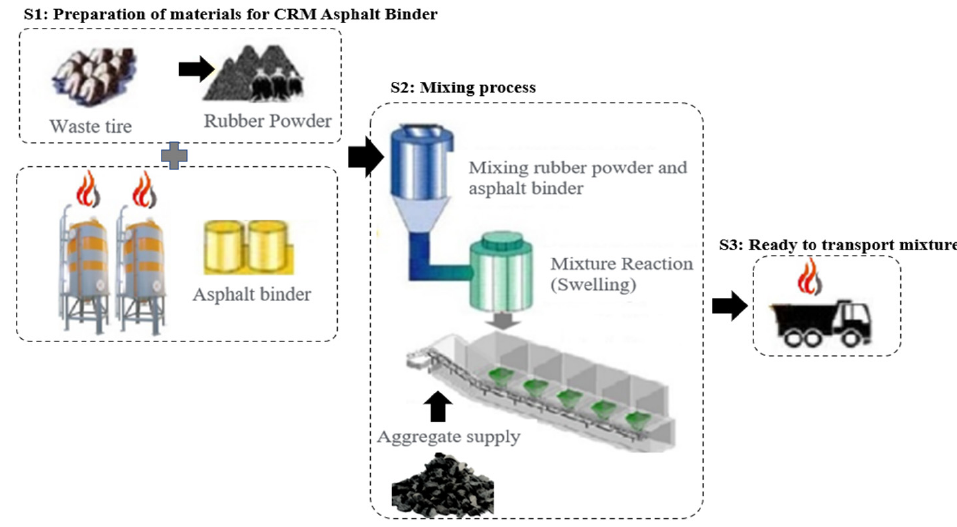
Figure 3. CRM asphalt pavement manufacturing